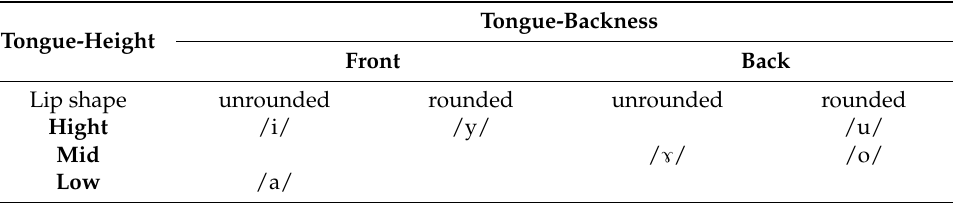
Table 1. Monophthongs and articulations in Mandarin